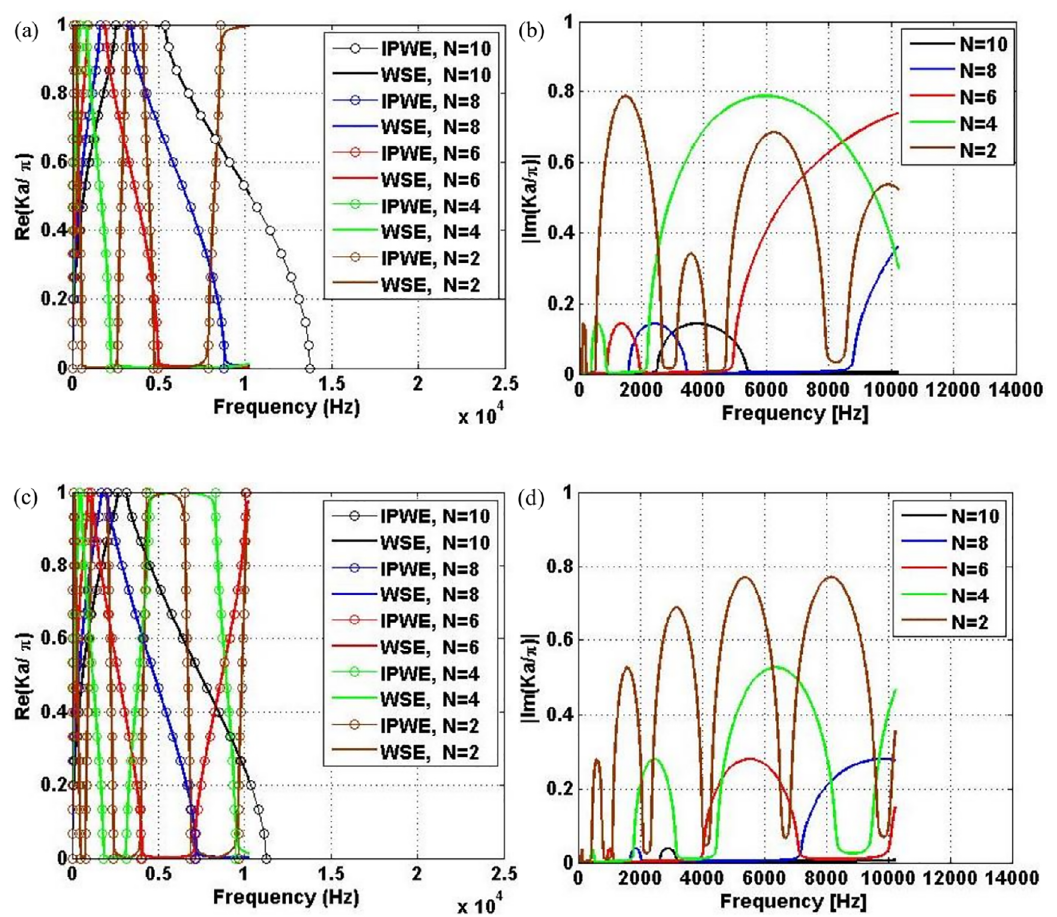
Figure 8. Complex elastic band structure of the PC beam considering N = 2, 4, 6, 8, 10 for models 1 (a-b) and 2 (c-d). The real part of the reduced Bloch wave vector (dimensionless) (a-c) is calculated by WSE and IPWE methods and the imaginary part of the reduced Bloch wave vector is calculated by WSE method